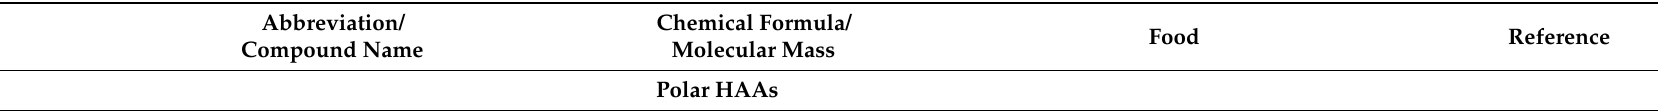
Table 1. Structure, abbreviation, compound name, chemical formula, molecular mass, and presence of polar and non-polar HAAs in